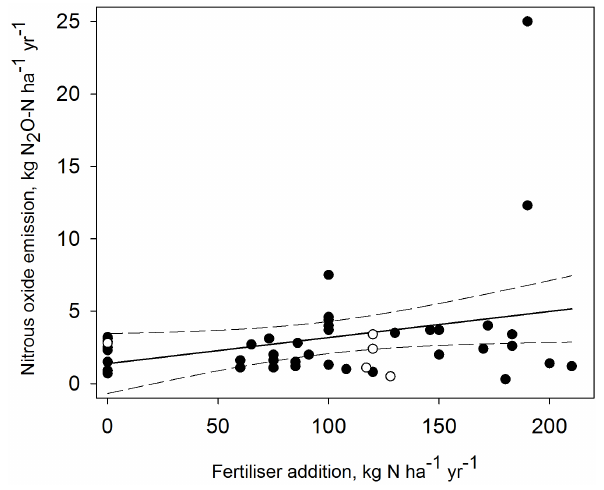
Fig. 4. Compiled measurement data on nitrous oxide emissions from cereal and rape crops in northern Europe and Canada, plot- ted against N fertiliser addition. White spots denote Swedish data. Linear regression and 95% confidence interval; emission of N 2 O- N=1.4+(0.02 · N in fertiliser), r 2 = 0 . 08 and P = 0 .